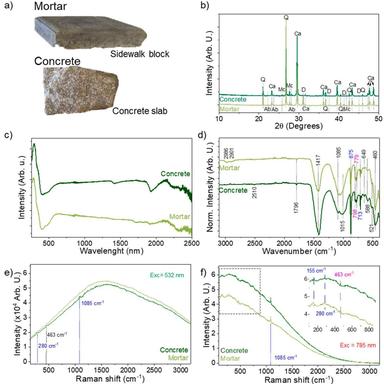
Concrete-based material group (concrete 1 and concrete 2) characterization composed by a) photographs, b) X-Ray diffraction patterns, c) FTIR, d) UV-SWIR, e) Raman spectra with 532 nm excitation source and f) Raman spectra with 785 nm excitation source. Legend: XRD: Q: quartz, Ca: calcite, D: dolomite, MC: microcline and Ab: albite.